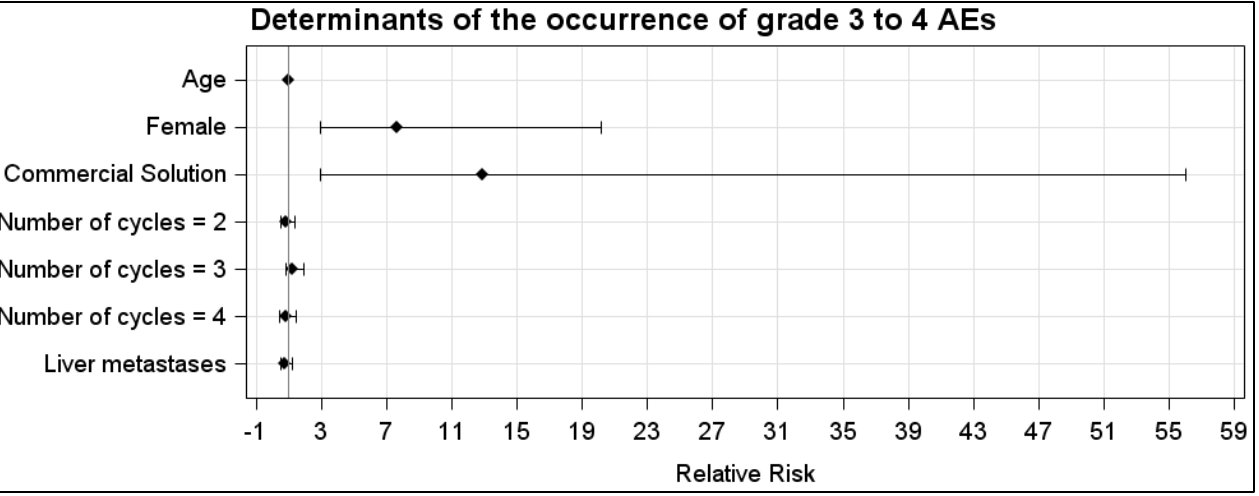
Figure 4. Relative risk calculated with Poisson regression for grades 3 and 4 in the LysArg group compared to the CS group. Determinants were age, gender, number of cycles and presence of liver metastasis.